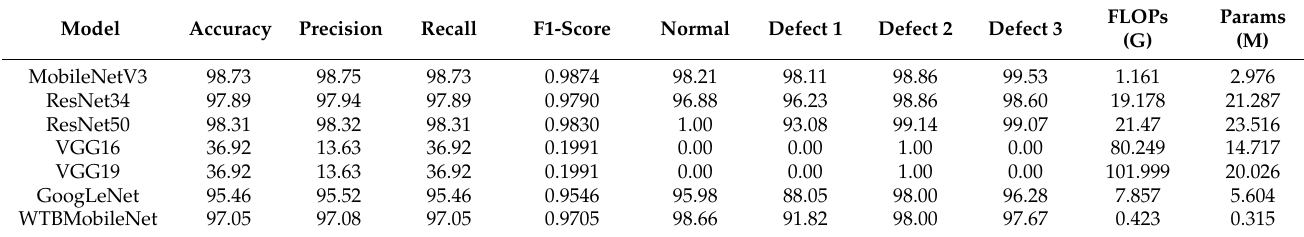
Table 5. Performance of baseline comparison on spectrogram